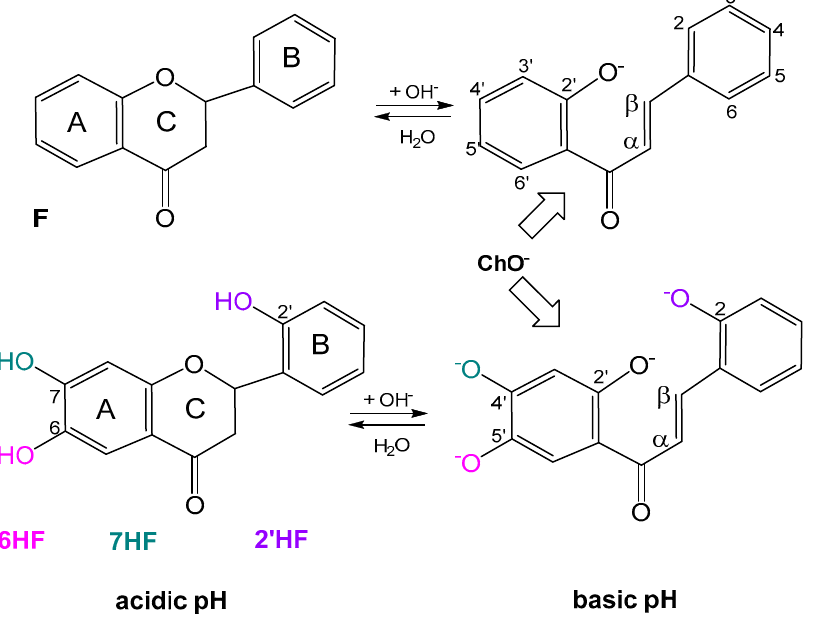
Figure 3. Overview of formation of chalcones for: F, 6HF, 2’HF and 7HF. Different colors refer to: 6HF ( magenta ); 2’HF ( violet ) and 7HF ( green ), respectively. (ChemDraw).